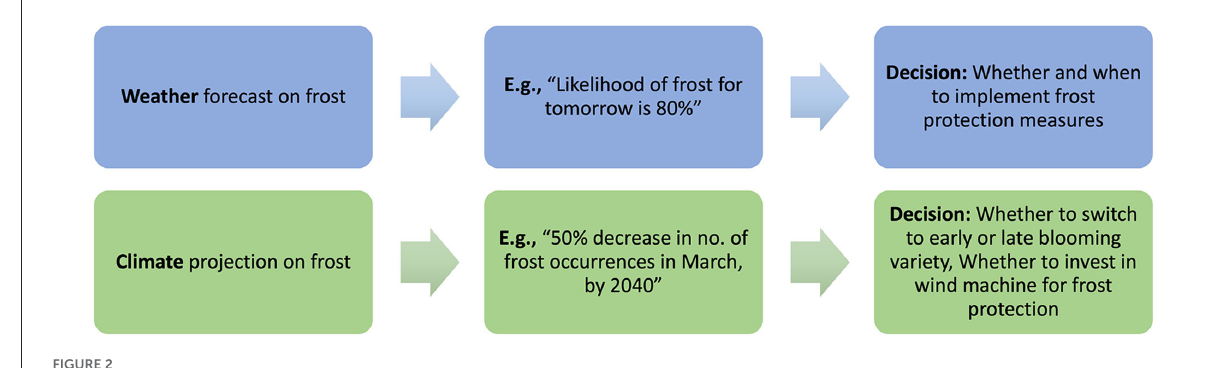
FIGURE2 Figure illustrating the different between the form and use of a weather forecast vs. a climate projection for